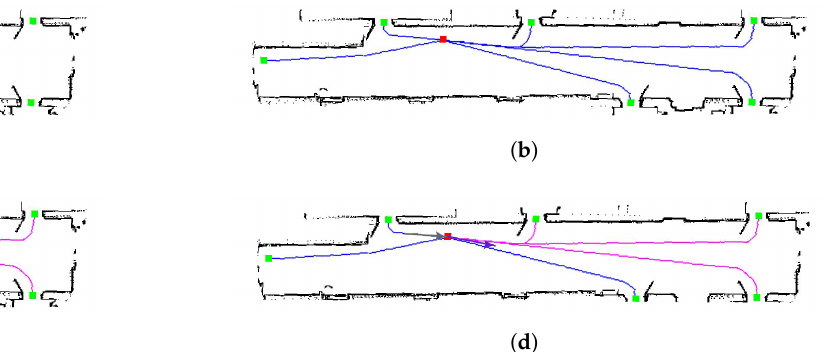
Figure 12. Results for a navigation-based trajectory prediction using the A* algorithm, where the green squares show the possible goals in the environment a people can reach; the red squares show the estimated position of the person sensed; the blue lines show the paths with less probability of being followed; and the magenta lines show the paths with a greater probability of being followed. The gray arrow is the tracked path and the purple arrow is the head orientation. ( a ) Empty environment with possible destinations; ( b ) trajectory prediction using A* algorithm based on the pose estimation and possible goals in the environment. With no variables other than position estimation, all destinations have the same chance of being reached; ( c ) trajectory prediction using A* algorithm based on the pose estimation, possible goals in the environment and head orientation. Taking into account the estimation of the person’s position in the environment and the orientation of the head, it is possible to reduce the destinations that can be reached; ( d ) trajectory prediction using the A* algorithm based on the pose estimation, possible goals in the environment, head orientation and tracked